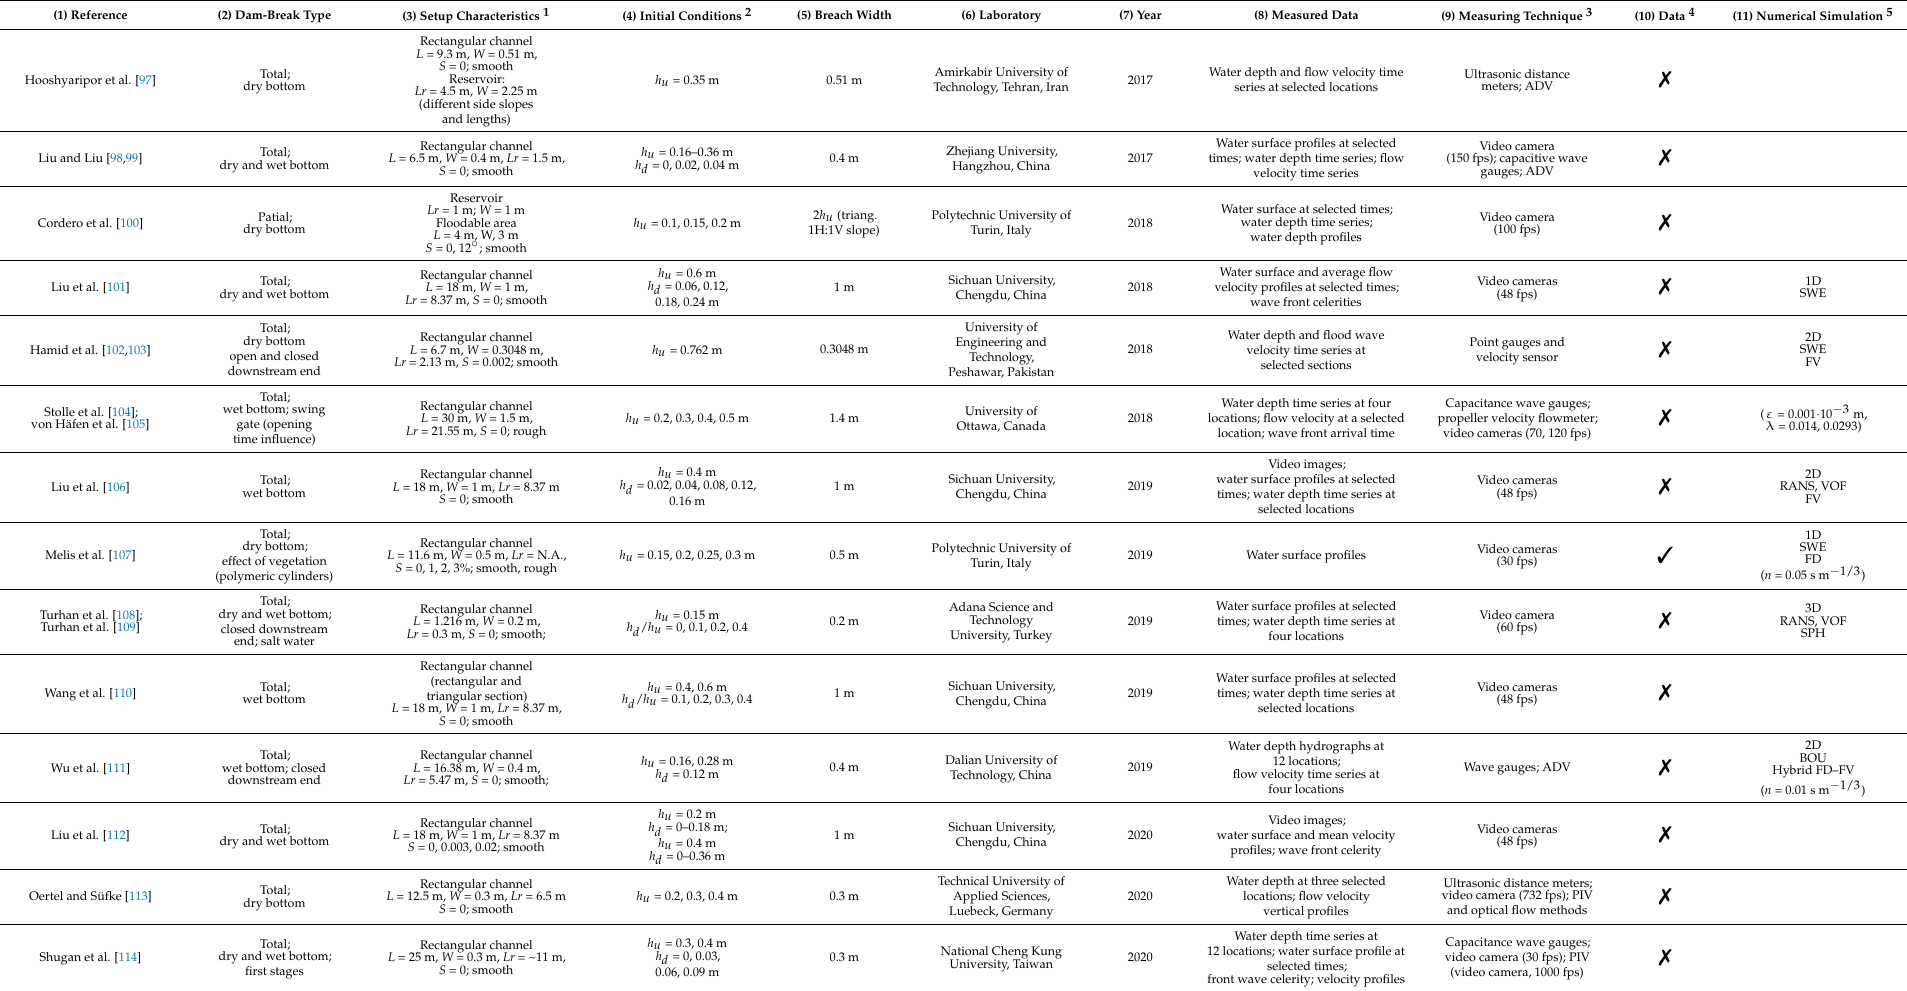
Table 1. Basic experimental investigations of fundamental dam-break wave physical characteristics.